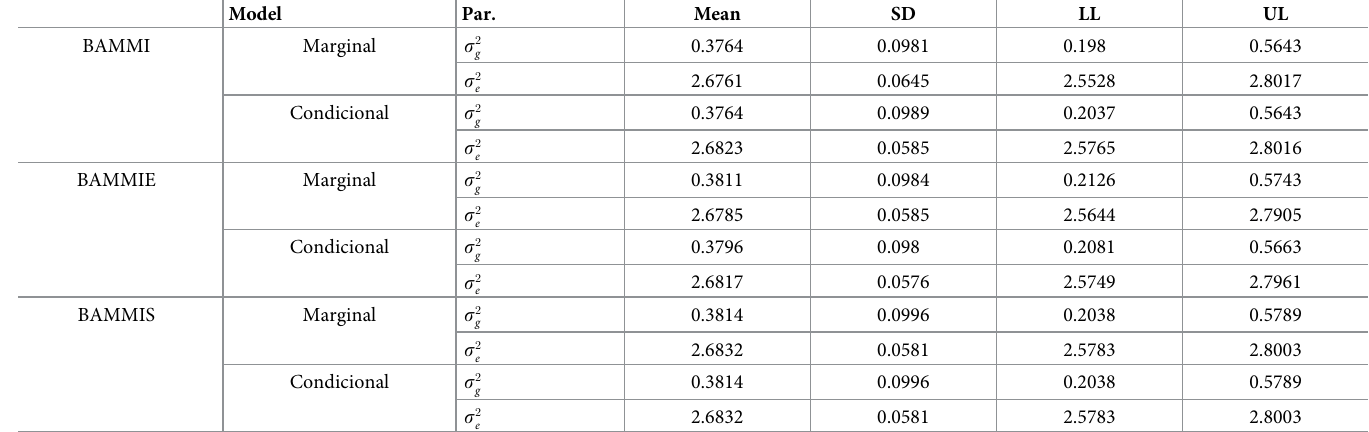
Table 5. Point estimate and interval estimate (HPD at 95% probability) for the variance genotypic ( s 2 ditional and marginal responses, for the three Bayesian AMMI